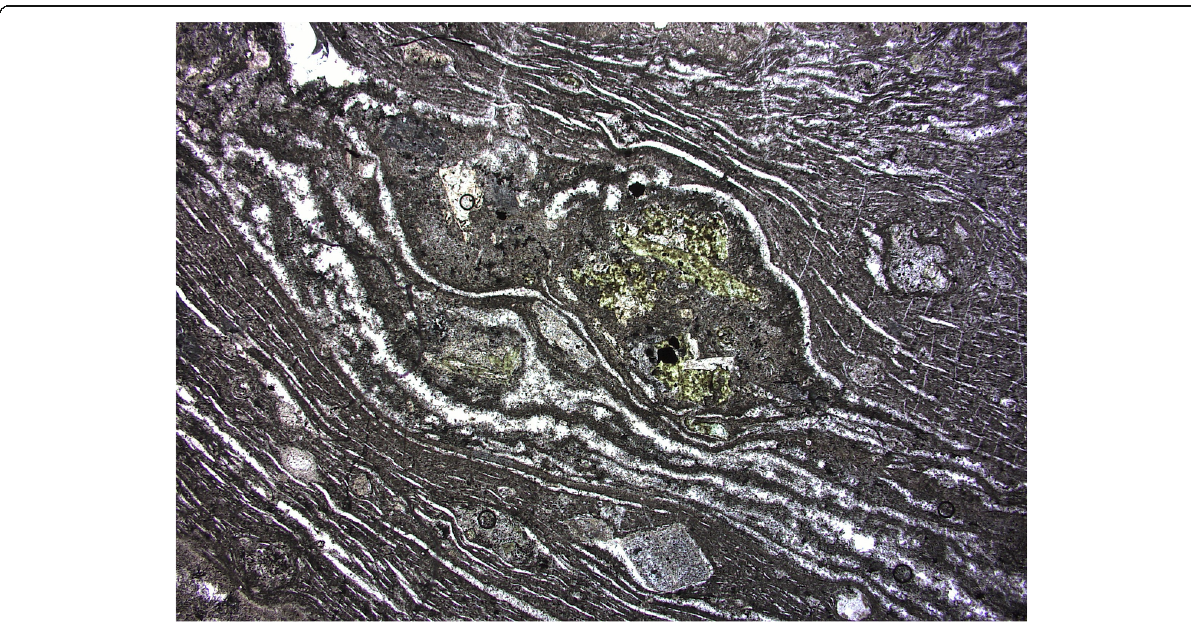
Fig. 7 Thin section, showing an eutaxitic texture from a densely welded pyroclastic flow deposit (upper part in Fig.